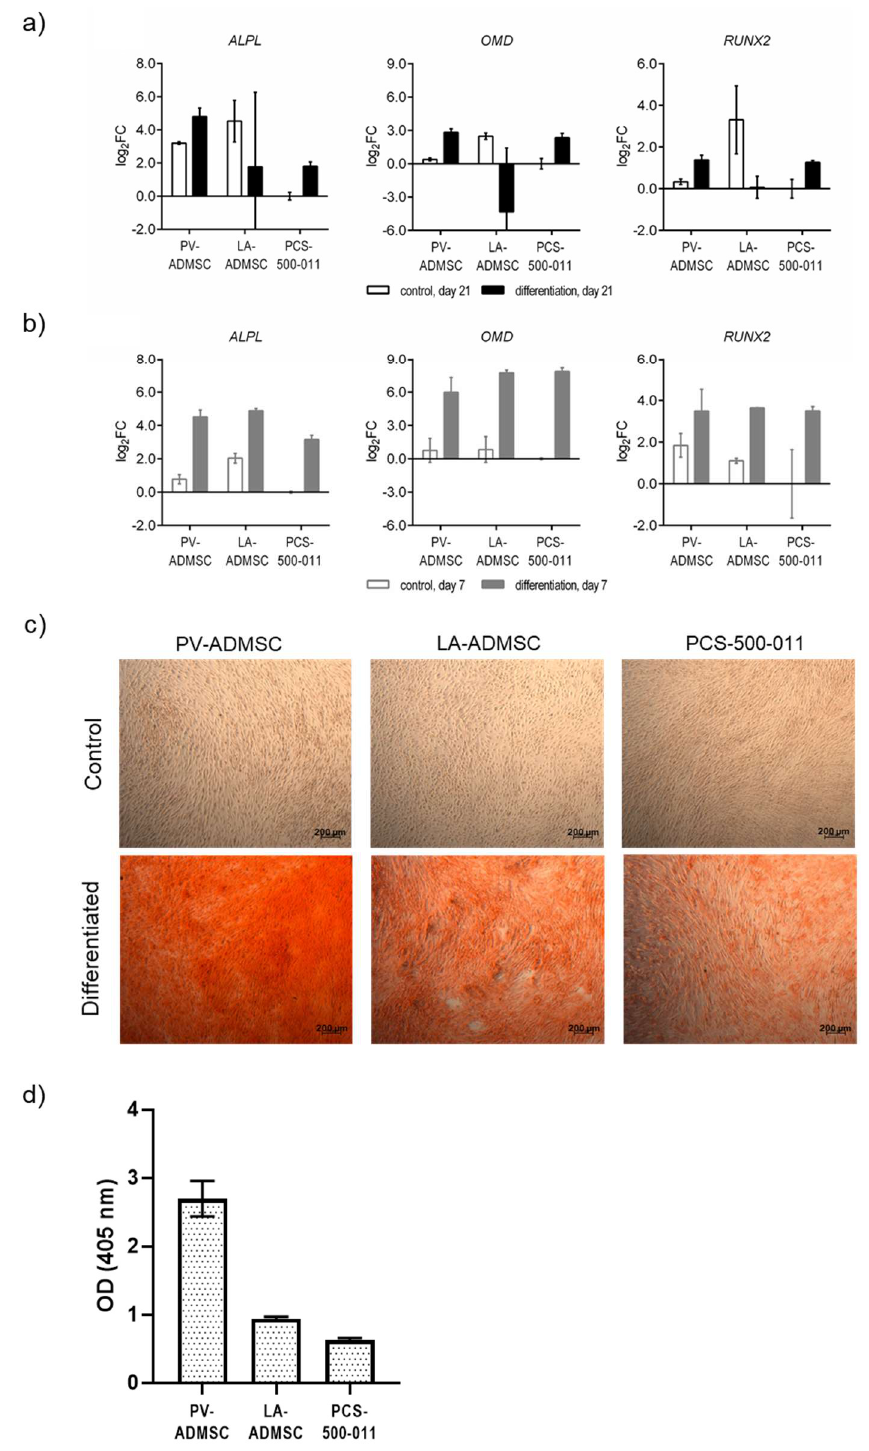
Figure 5. Osteogenic differentiation of human ADMSCs. ( a ) The mRNA expression of ALPL , OMD and RUNX2 in human ADMSCs after 21 (days) and ( b ) 7 days of differentiation. The results are normalized to the control (undifferentiated) PCS-500-011 cells on day 7 and 21, respectively ( n = 2). ( c ) After 21 days of incubation in either standard or differentiation medium, cultures were fixed and stained with Alizarine Res S (ARS). Calcium deposits are stained in red. ( d ) Quantification of ARS was performed by extracting the mineral deposits with acetic acid and measuring the absorbance at 405 nm. Data are given as mean ( n = 2), with error bars representing standard deviation.